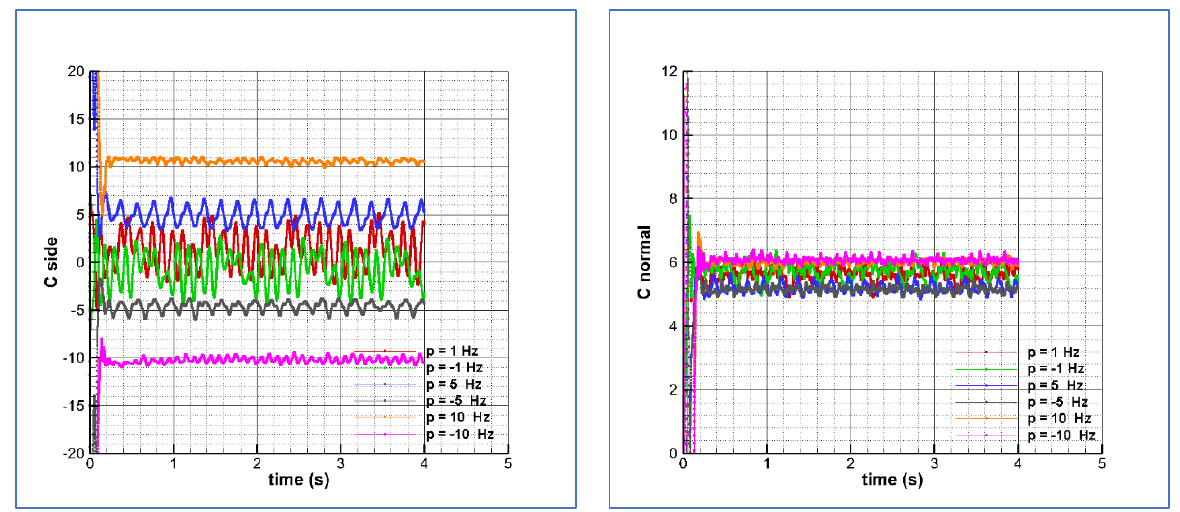
Figure 7. Side ( left ) and normal ( right ) force coefficients versus time at Ma = 0.2, Re =2 × 10 6 and α = 35 deg. α = 35 deg.